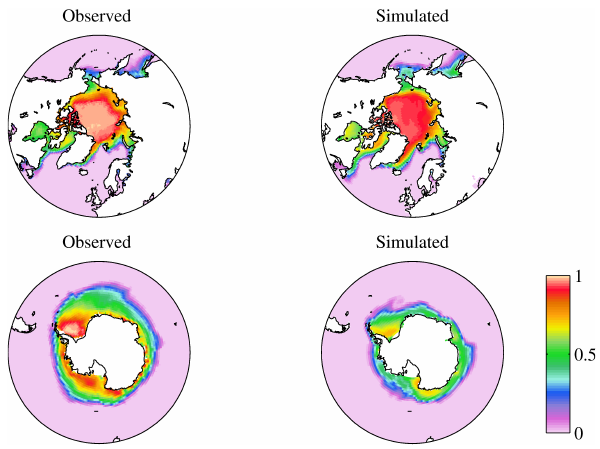
Fig. 6. Observed (left) and simulated (right) Arctic (top) and Fig.5. Observed( left )andsimulated( right )Arctic( top )andAntarctic( bottom )sea–icecoveraveragedfortheperiod Antarctic (bottom) sea-ice cover averaged for the period 2000–2009 2000–2009 inclusive. Sea–icecoverisnon–dimensional. inclusive. Sea-ice cover is